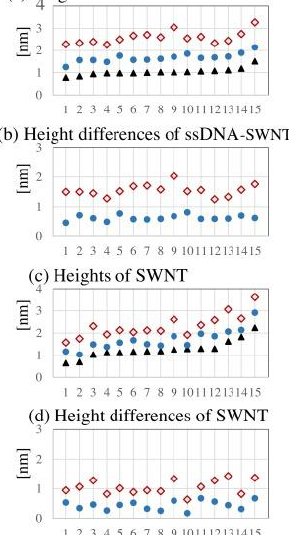
Figure 2. Height values obtained by simultaneous imaging of individual ssDNA-SWNT hybrids and bare SWNT molecules by three different measurement conditions. X-axis indicates No. of individual hybrid. Y-axis indicates heights (( a ) and ( c )) and height differences (( b ) and ( d )). ( a ) Heights of ssDNA-SWNT hybrids. Red rhombuses: intermittent contact mode in TE buffer. Blue circles: non-contact mode in air. Black triangles: intermittent contact mode in air; ( b ) Subtracted height values of ssDNA-SWNT hybrids between two different atomic force microscopy (AFM) force conditions. Red rhombuses: subtraction between intermittent contact mode in TE buffer and intermittent contact mode in air. Blue circles: subtraction between non-contact mode in air and intermittent contact mode in air; ( c ) Heights of bare SWNTs. Red rhombuses: intermittent contact mode in TE buffer. Blue circles: non-contact mode in air. Black triangles: intermittent contact mode in air; ( d ) Subtracted height values of bare SWNT molecules between two different AFM force conditions. Red rhombuses: subtraction between intermittent contact mode in TE buffer and intermittent contact mode in air. Blue circles: subtraction between non-contact mode in air and intermittent contact mode in air. Maximum heights were obtained with intermittent contact mode in an aqueous solution (reprinted from reference [48] with permission).